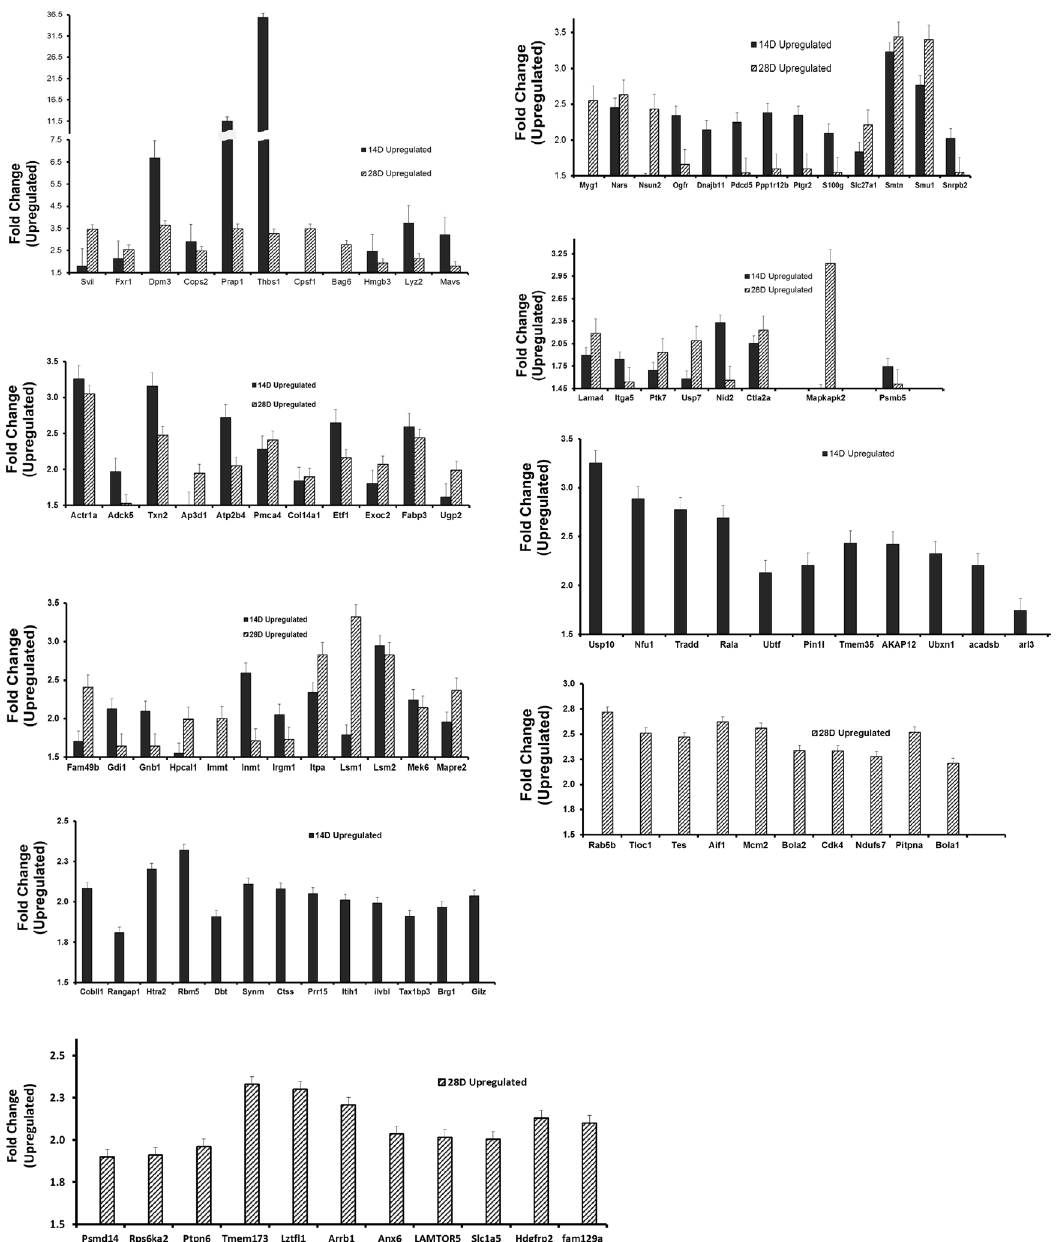
Fig 6. Chlamydia infection caused the altered expression of proteins that regulate epithelial functional integrity and pathologic EMT in the reproductive system (up-regulation). The quantitative differential proteomics with isobaric tags for relative quantitation (iTRAQ) labeling and LC-MS analysis was used to identify proteins that were differentially expressed in the oviducts from chlamydial infected mice, as previously described [103,104]. Briefly, trypsinized proteins extracts were labeled using the 114, 115, 116 and 117 iTRAQ tags and analyzed by MS, as described in the materials and Methods section. Protein/peptide identification and quantification were performed with the Protein Pilot Software version 4.5 and MASCOT, including the search of the database for murine or human proteins (http://www.uniprot.org). Fold Change represented protein expression in infected oviducts divided by protein expression in uninfected oviducts. The down-regulated molecules were expressed in percentage to avoid negative values. Only protein identified by at least 2 peptides and with a P-value < 0.05 were used for quantitation. The biological and functional properties of the proteins and their physiological and disease pathways were established through http://www.elsevier.com/online-tools/pathway-studio (Pathway studio 10; www.elsevier.com/online-tools/ pathway-studio) and other specialized biomedical databases that include PubMed and Medline searches. Results show molecules upregulated at D14 and D28